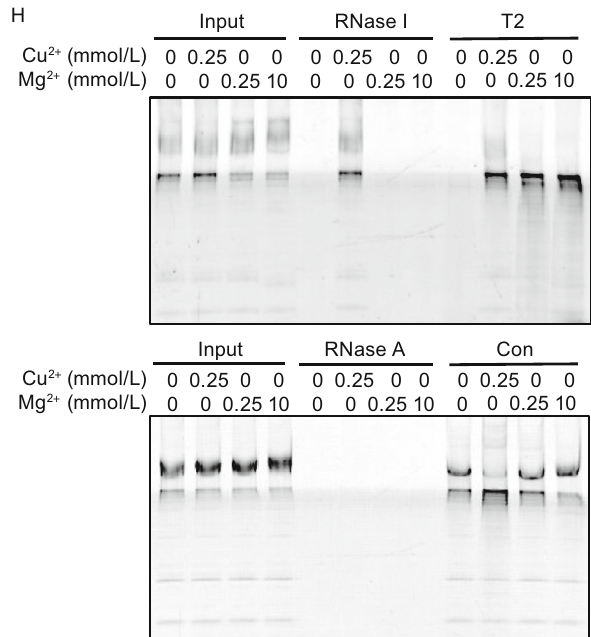
Figure 6. Characterization of RNASET2 puri fi ed from HEK mitochondria. (A) Dual-tag puri fi cation of RNASET2 (His and HA). Puri fi cation was performed using IMS from control HEK cells (C) or RNASET2-overexpressing cells (T2) under native condition. (B) Ribonuclease activity were examined in IMS samples and the puri fi cation samples (Eluate) from control HEK cells (C) or RNASET2-overexpressing cells (T2) using biotiny- lated UCP2 mRNA as a substrate. The sensitivity of these activities to Cu 2+ (0.5 mmol/L) and proteinase K (ProK) was also tested. (C) RNASET2 was puri fi ed from RNASET2- overexpressing mitochondria under denaturing condition and checked for ribonuclease activity using RNA puri fi ed from isolated mitochondria as substrates; C (control pulldown from HEK mitochondria) and T2 (RNASET2). (D) RNASET2s puri fi ed under native conditions and denaturing conditions had the same responses to proteinase K (ProK) and Cu 2+ treatment. Lower panel is a coomassie staining gel of mitochondrial lysates as a positive control for proteinase K treatment. (E) Effect of temperature on RNASET2 puri fi ed from HEK mitochondria, RNaseI, and RNaseA (50 ng). Degradation was performed at 37°C (the temperature used for the other exper- iments if not speci fi ed) or 25°C. RNAs puri fi ed from isolated mitochondria were used as substrates. Con (control pulldown from HEK mitochondria). (F) Effect of pH on RNASET2 puri fi ed from HEK mitochondria, RNaseI, and RNaseA. Degradation was performed at pH 7.4 (the pH used for the other experiments if not speci fi ed), pH 6.5 or pH 5.5. (G) Effect of ATP on RNASET2 puri fi ed from HEK mitochondria, RNaseI and RNaseA. (H) Effect of Mg 2+ and Cu 2+ on RNASET2 puri fi ed from HEK mitochondria, RNaseI and